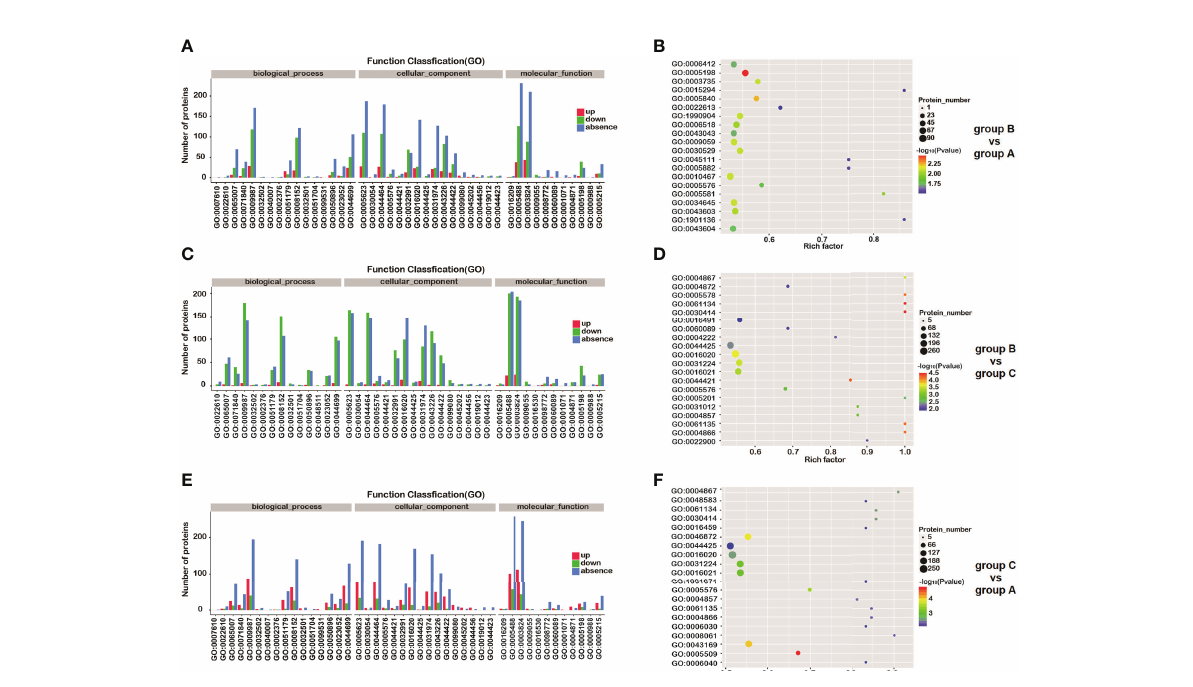
FIGURE 4 GO analysis of differentially expressed proteins (DEPs). Distribution of GO annotation of the DEPs identi fi ed in group B vs group A (A) , group B vs group C (C) and group C vs group A (E) . Red and green bars represent up- and down-regulated proteins, respectively. Blue bar represents unique proteins detected in a single group. GO enrichment of differentially expressed proteins in group B vs group A (B) , group B vs group C (D) and group C vs group A (F) . The size of spots represents the number of proteins in each GO term. Different colors represent distinct P- values. GO numbers represent GO terms, which can be found in Gene